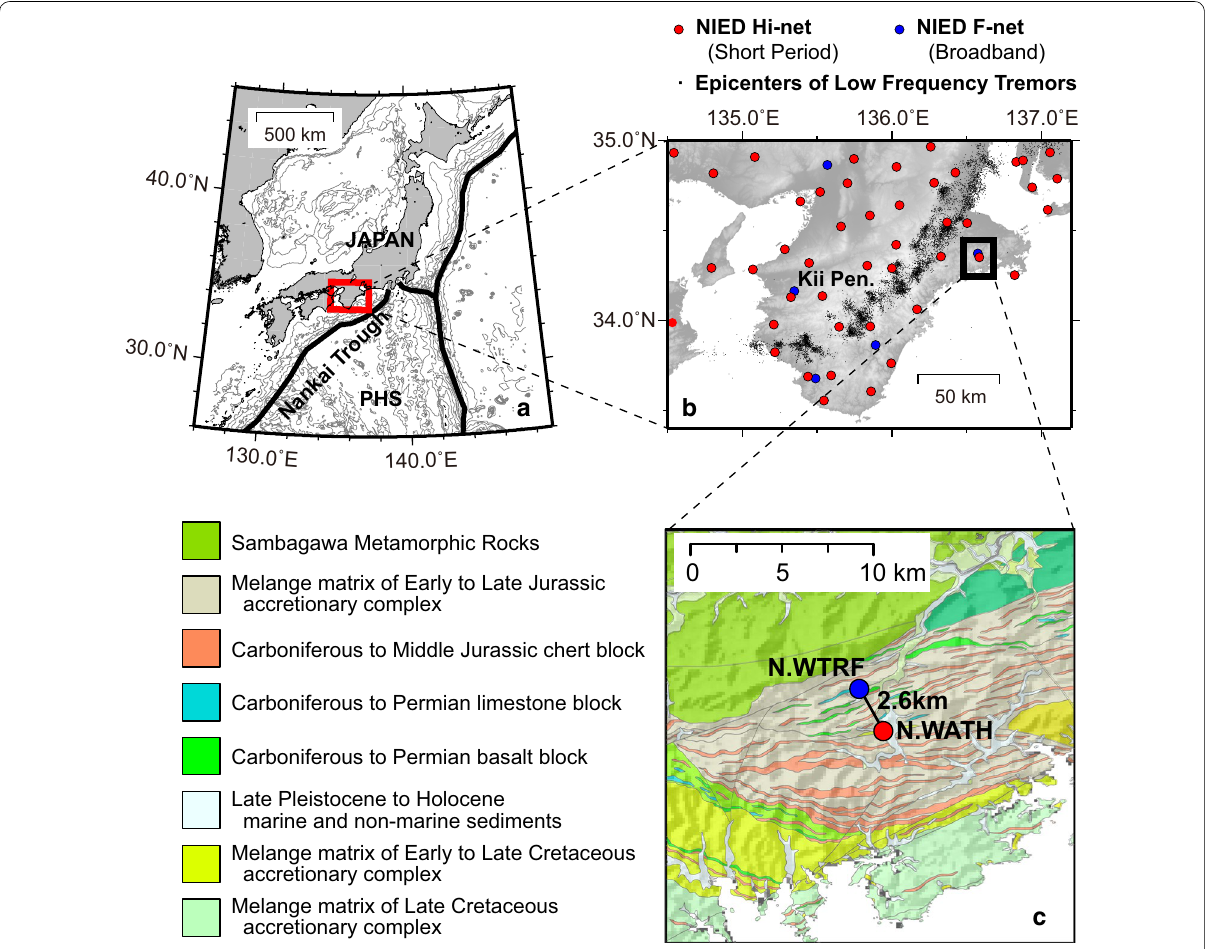
Fig. 1 Location of target stations. a Map of the Japan Islands. “PHS” means Philippine Sea plate, which is subducting beneath the southwestern part of Japan from the Nankai Trough. b Map of the Kii Peninsula. Red and blue circles indicate the locations of the NIED Hi-net and F-net stations, respec- tively. Black dots denote epicenters of low-frequency tremors (Maeda and Obara 2009). c Detailed locations of N.WTRF ( blue circle ) and N.WATH ( red circle ) on a geological map (Geological Survey Japan, AIST ed. 2015). Colors correspond to the surface